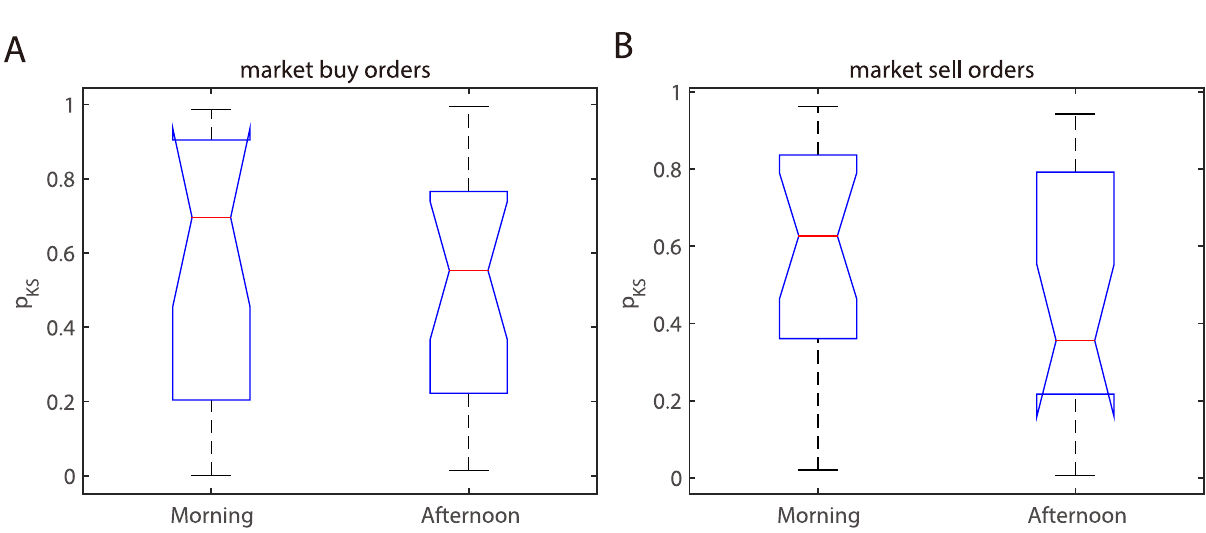
Fig 5. The p -values of the Kolmogorov-Smirnov test on the 21 sample days. A: aggressive market buy orders. B: aggressive market sell orders.